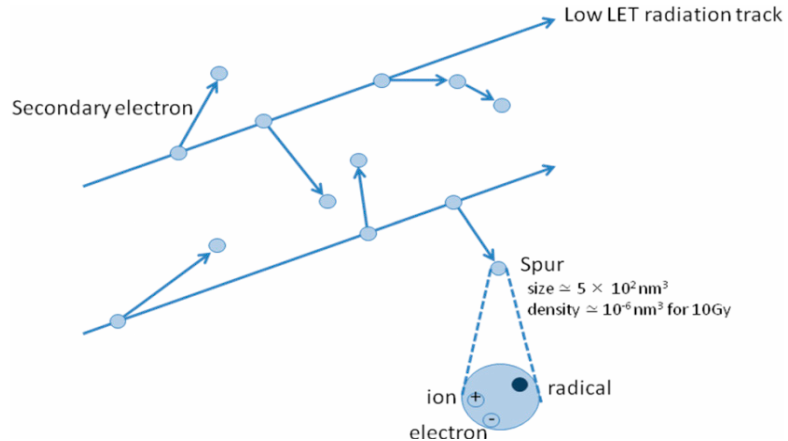
Figure 20. Schematic representation of the tracks of LET radiation and